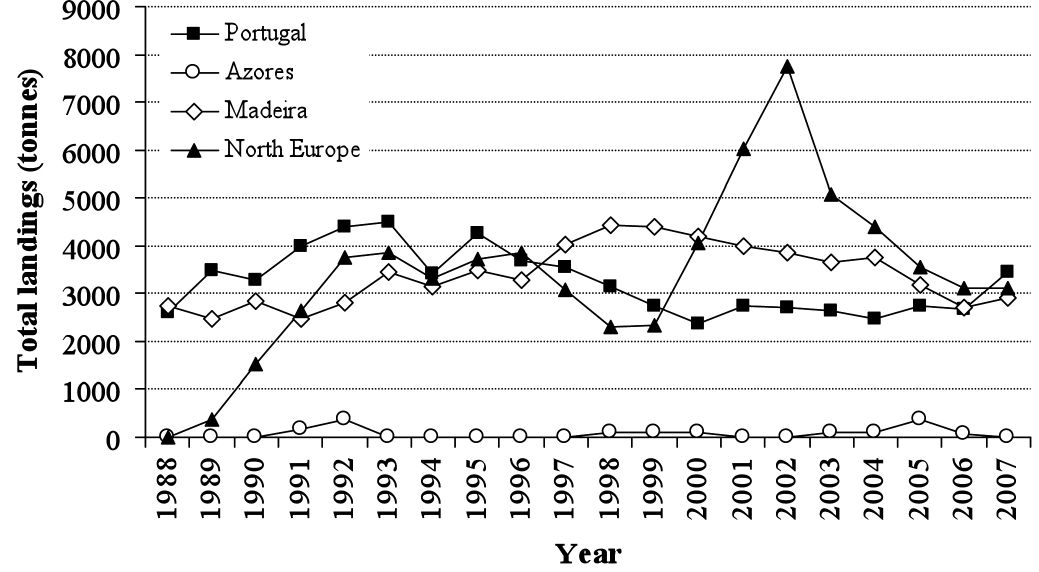
Fig . 2. – Total landings (tonnes) reported by mainland Portugal, Madeira, the azores and northern europe (subareas II, IV, V, VI and VII combined) for the last 20-year period. Sources for Madeira data: dreM (2008); other data: ICeS